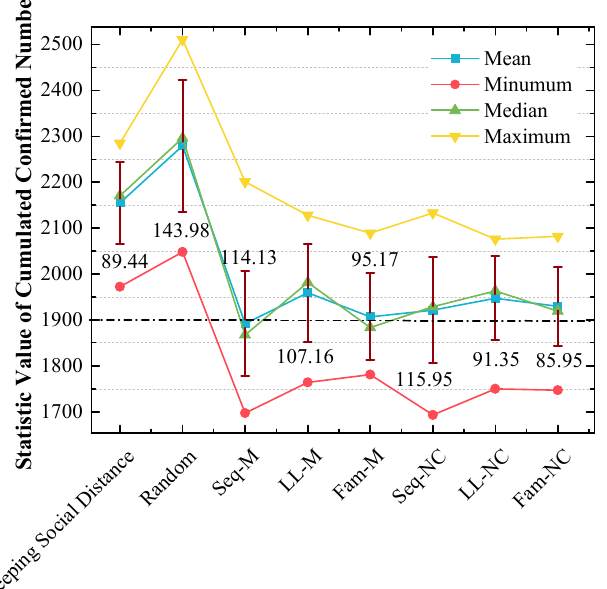
Figure 9. Statistical analysis of cumulated confirmed numbers using different strategies in the 1st scenario. The red lines express the standard variances of cumulative confirmed numbers.